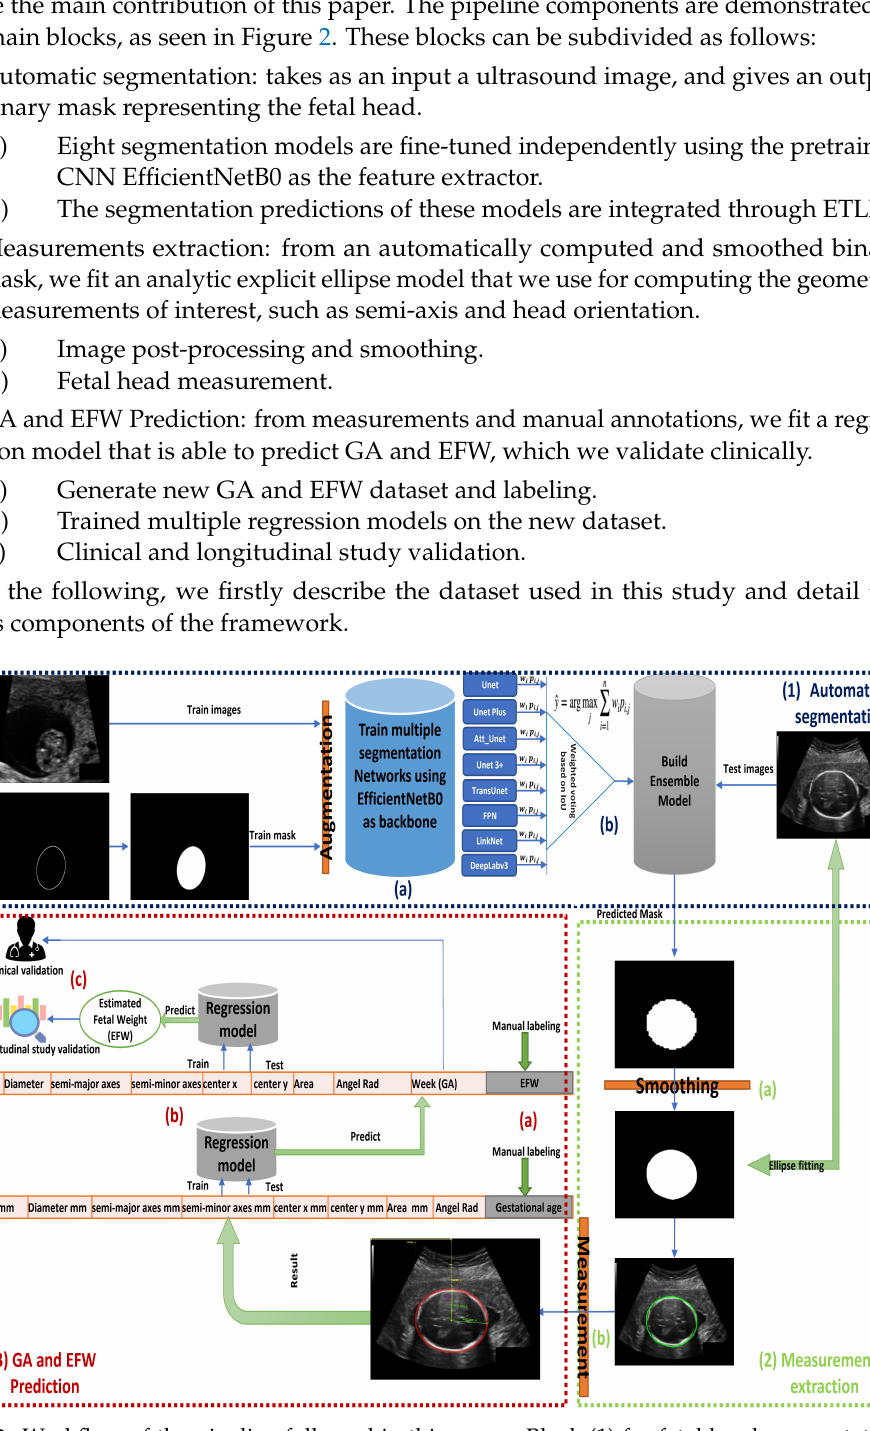
Figure 2. Workflow of the pipeline followed in this paper: Block (1) for fetal head segmentation. Block (2) for smoothing and measuring. Block (3) for fetal GA and weight prediction